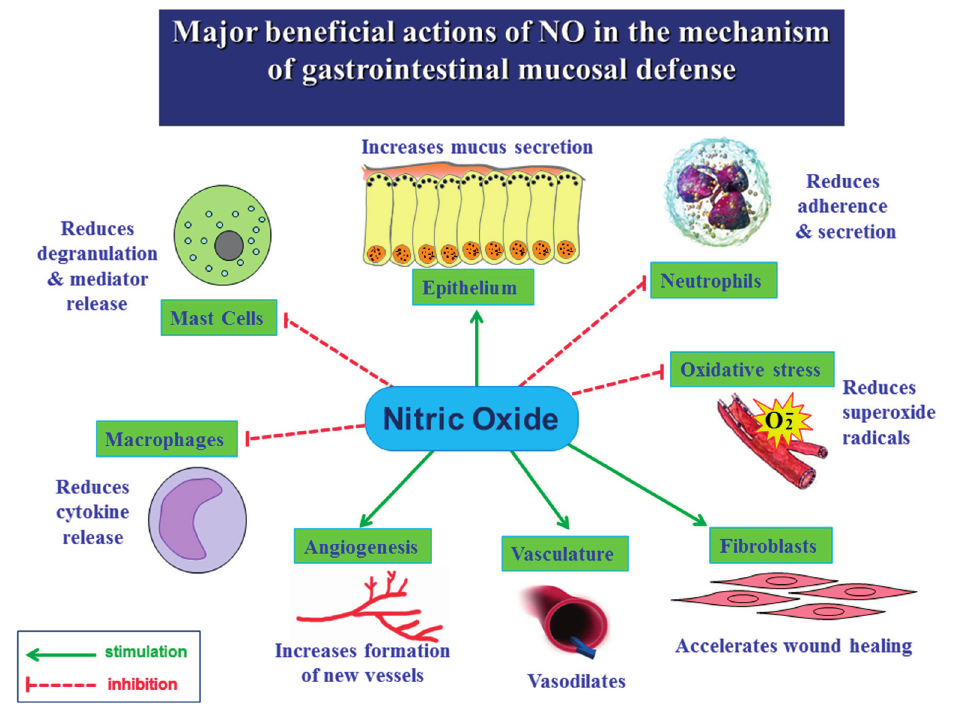
Figure 1. Beneficial actions of nitric oxide (NO) in the mechanism of gastrointestinal mucosal